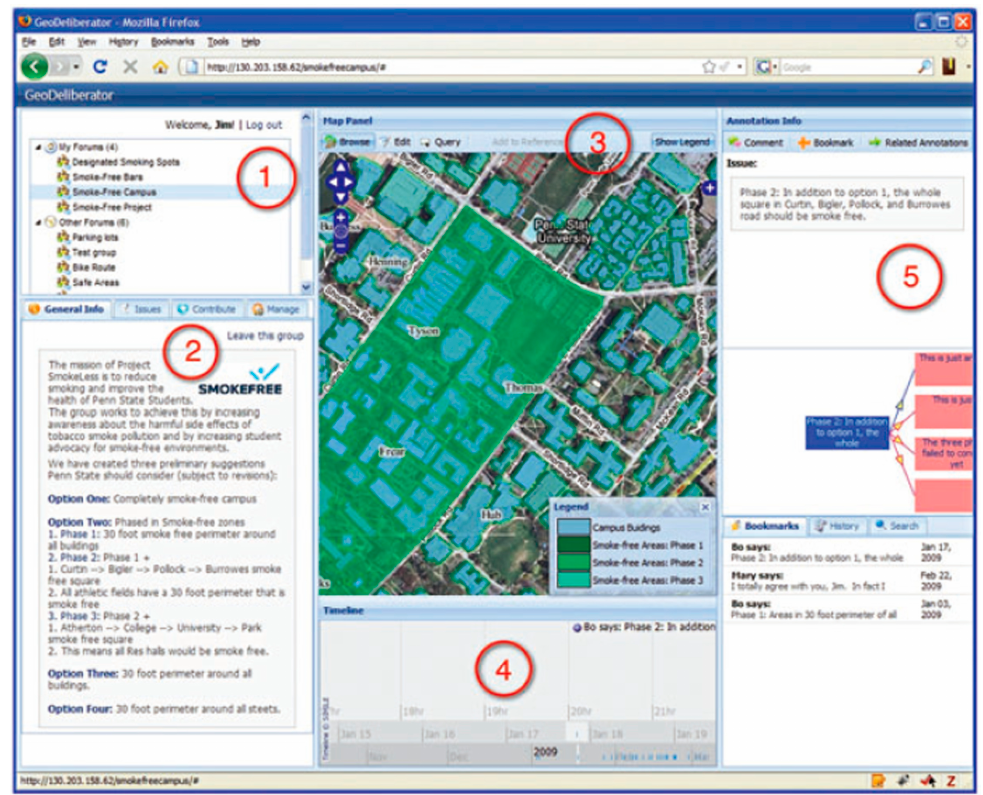
Figure 6. GeoDeliberator’s User Interface: (1) User and Group Panel; (2) Project Panel; (3) Map Panel; (4) Timeline view; (5) Annotation info.